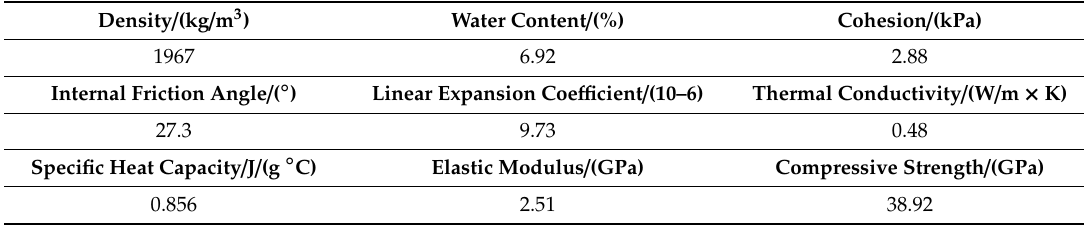
Table 3. Physical and mechanical parameters of specimens in slope.